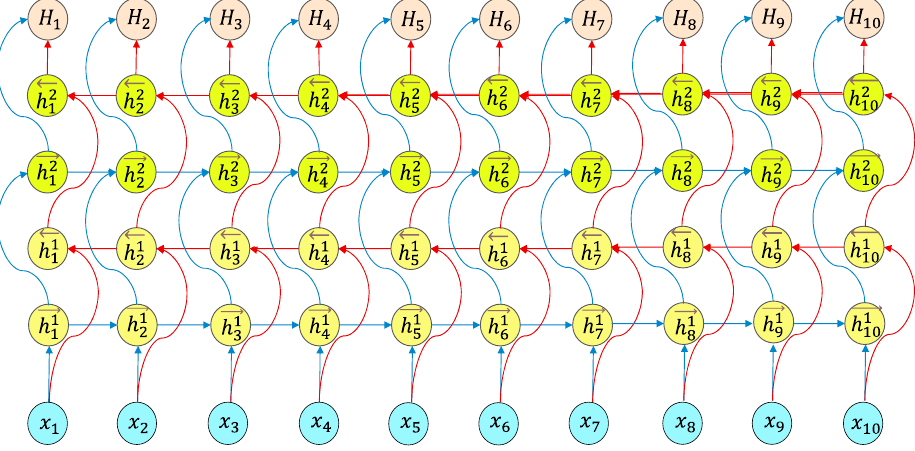
Figure 7. Graphical illustration of the Bi-LSTM layers used in the IE-Bi-LSTM model.